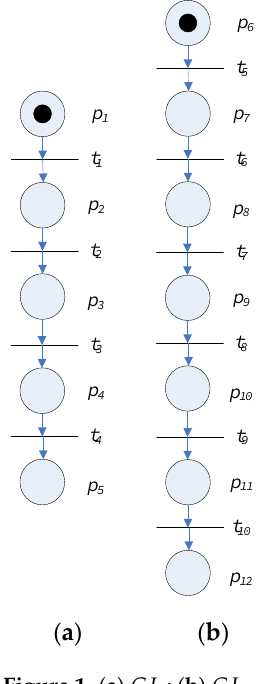
Figure 1. ( a ) 1 GJ ; ( b ) 2 GJ . Figure 1. ( a ) GJ